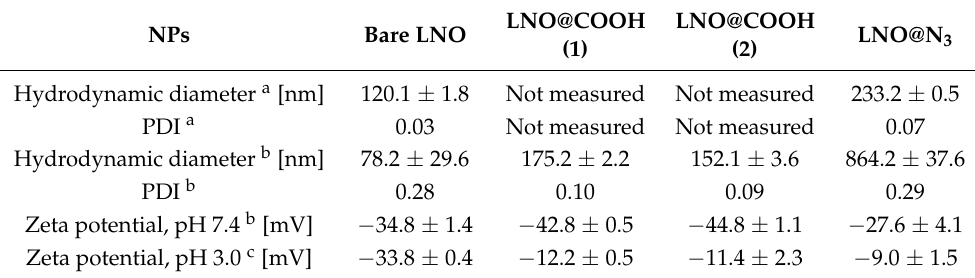
Table 1. DLS characterization of LNO@COOH and LNO@N 3